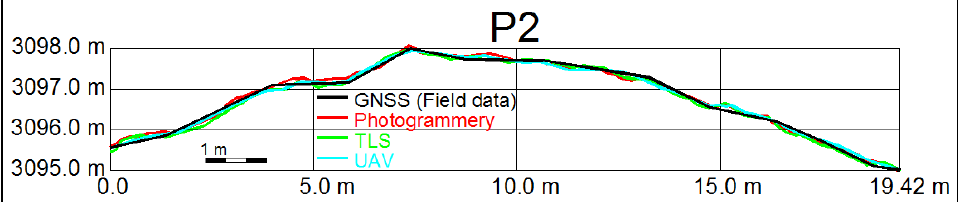
Figure 11. Comparison of profile 2 (Figure 5a) obtained using GNSS on the ground and the 3D models (MDE) of digital photogrammetry with Restitutor, TLS, and UAV.